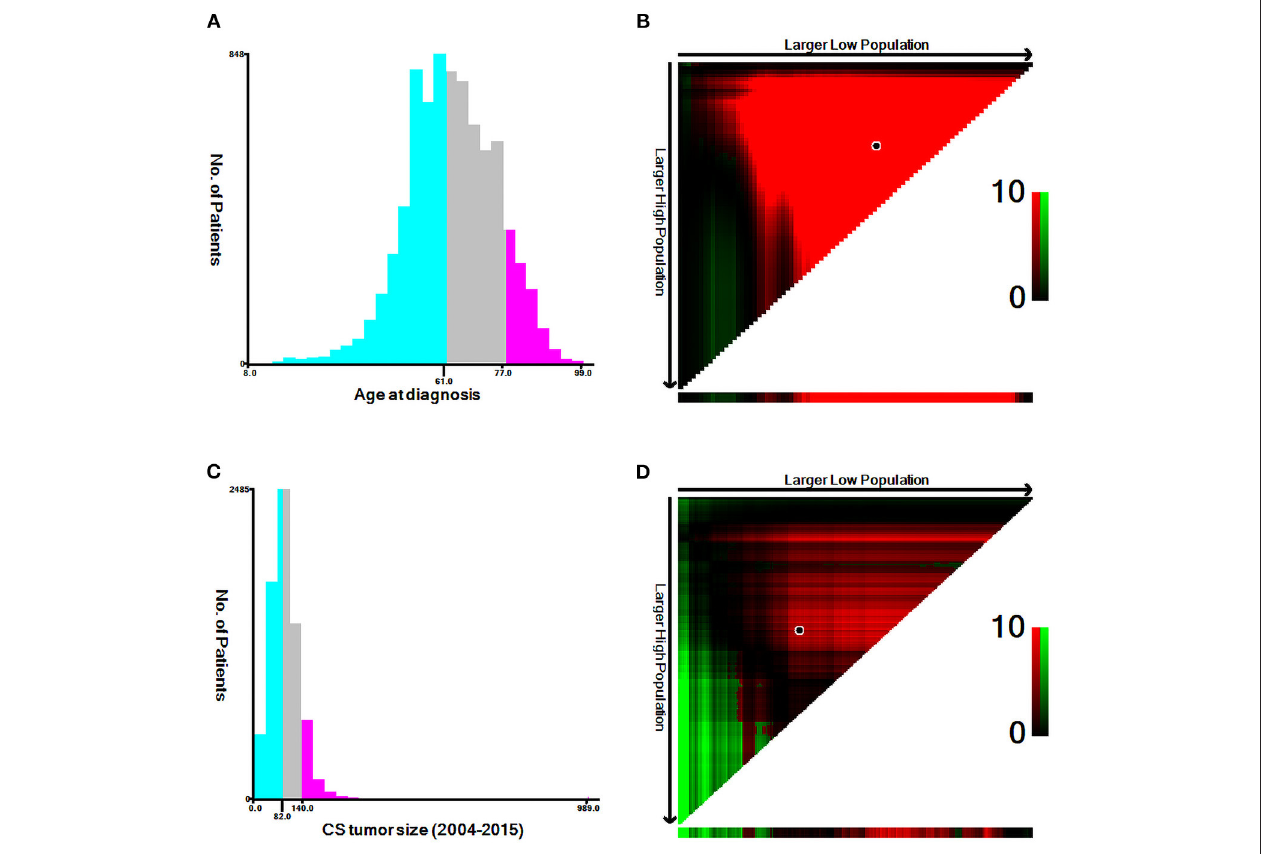
FIGURE 2 | Estimation of the appropriate cut-off value for the age and tumor size by using X-tile analysis. (A,B) The optimal cut-off values of age were 61 and 78 years. (C,D) The optimal cut-off values of tumor size were 82 and 141mm.